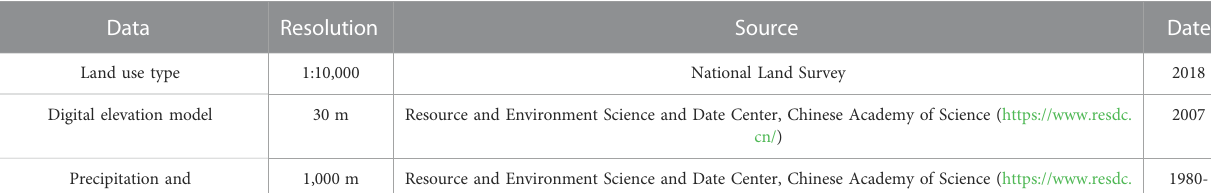
TABLE 1 Principal data sources in this study.